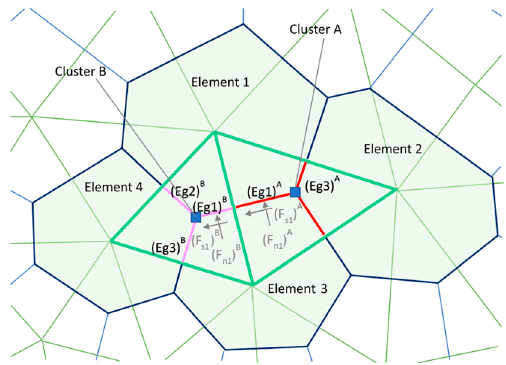
Figure 1. Definition of the potential fracture location in MDEM (Modified Discrete Element Method), showing the element definition, after failure. The arrows show the contact of normal and shear forces, F n and F s , respectively.